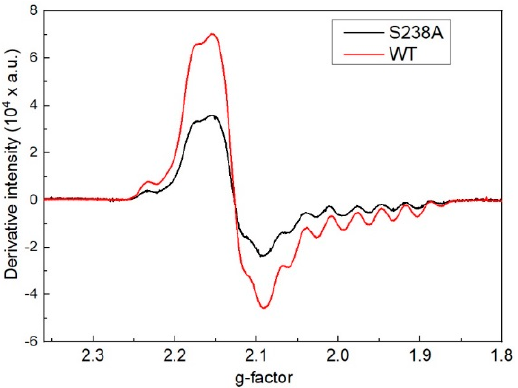
Figure 5. EPR spectra of S238A variant reaction with 4-thial-L-lysine at reaction time 8 s. EPR spectra of WT (red) and S238A (black) showing decreased signal intensity. The features of both spectra are identical. Experimental parameters: microwave frequency, 9.467 GHz; power, 2 mW; modulation, 8 G at 100 kHz; T = 80 K.